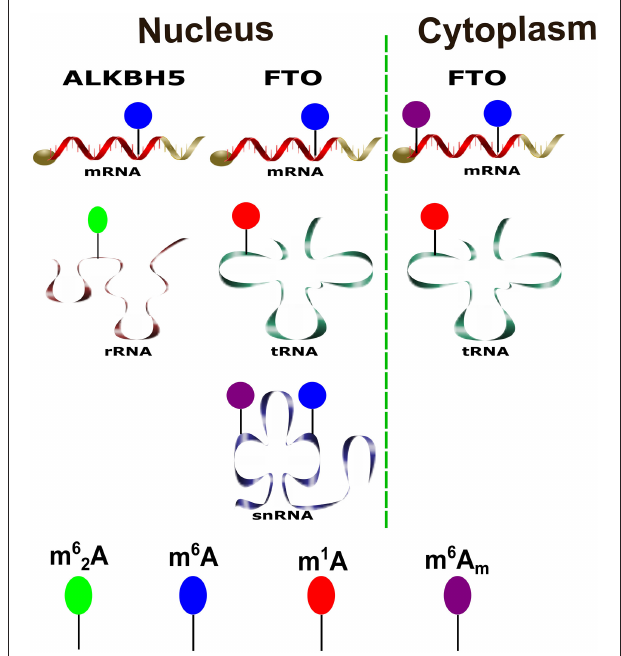
FIGURE 1 | Various physiological substrates of the m 6 A demethylases. A schematic diagram shows substrates of ALKBH5 and FTO and their distribution in both cytoplasm and nucleus to the different forms of RNAs inside the